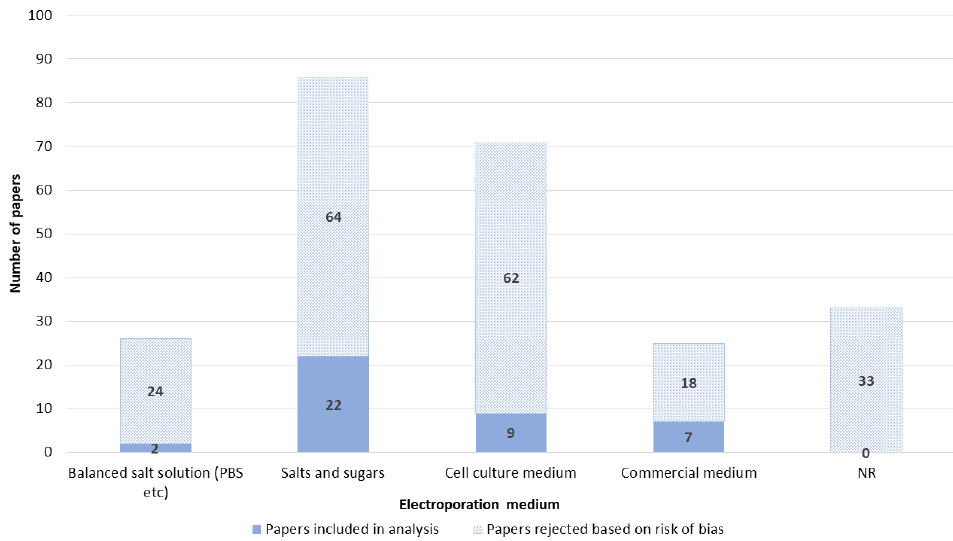
Figure 13. Electroporation medium. NR—not reported.